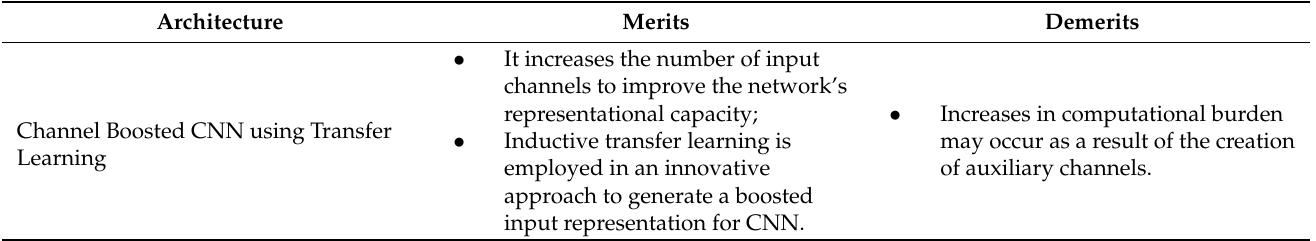
Table 7. Major issues linked with the deployment of channel-boosting-based CNN architectures.